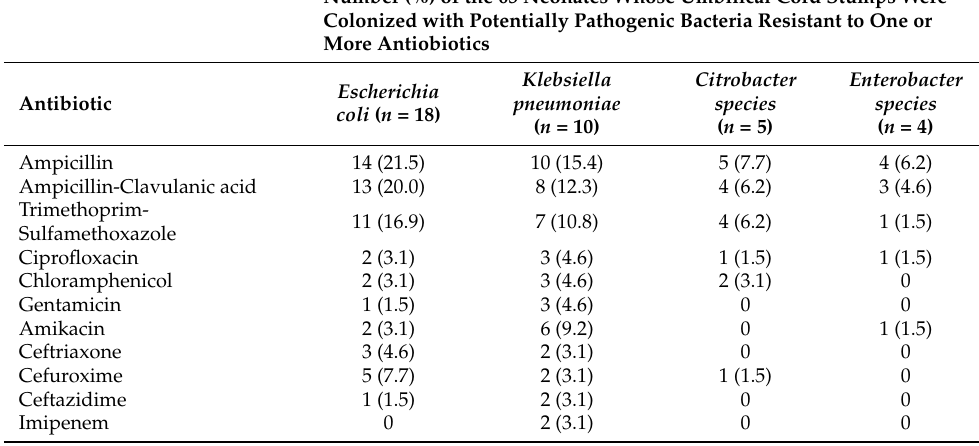
Table 2. Resistance patterns of organisms isolated from neonates with omphalitis at three study sites in central